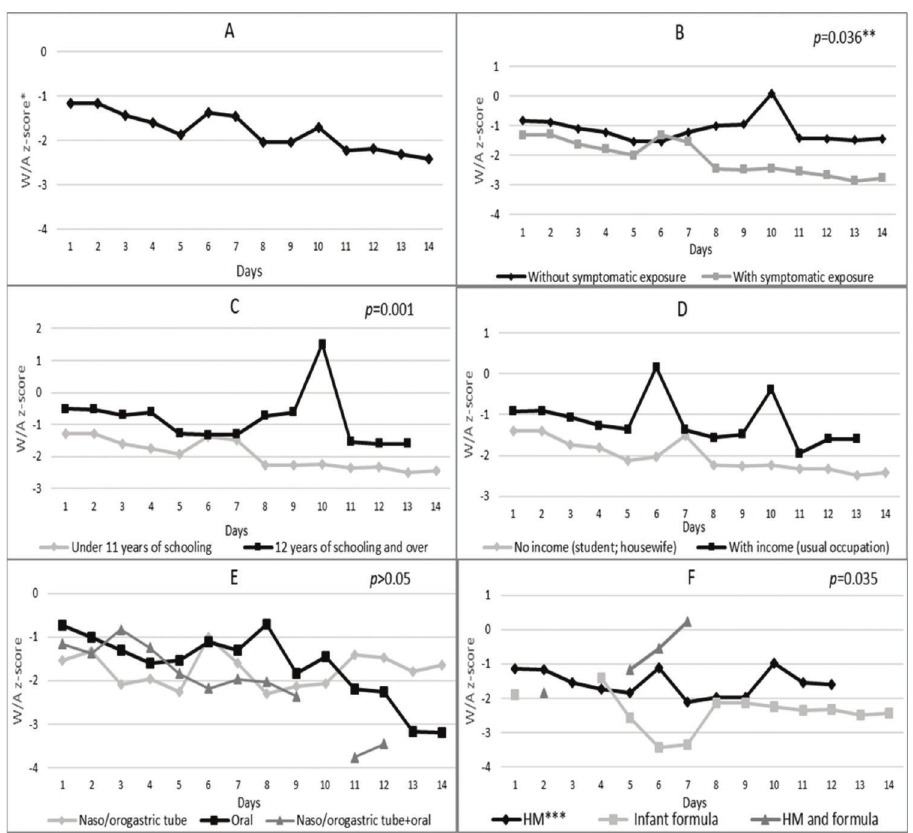
Figure 1 - Nutritional status (weight-for-age z-score) of microcephalic newborns at IFF/Fiocruz, Rio de Janeiro, Brazil, 2016: variation according to A – days of hospitalization; B – categories of exposure to Zika virus; C – maternal level of schooling; D – maternal income; E – diet administration route; and F – type of milk consumed during hospitalization. *W/A: weight-for-age; **generalized estimating equation model; ***HM: human milk; ****Broken lines in some charts are due to the lack of a newborn in that category on that day of